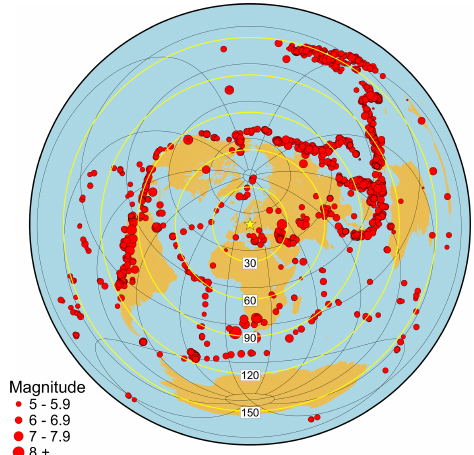
Figure 4. Distribution of the epicentres of M > 5 . 5 earthquakes in the period from 18 October 2017 to 26 October 2019, according to the ISC catalogue (1285 events). The yellow asterisk represents the centre of the AniMaLS seismic array in the Sudetes. The yellow circles mark the distances (in degrees) from the array centre in 30 ◦